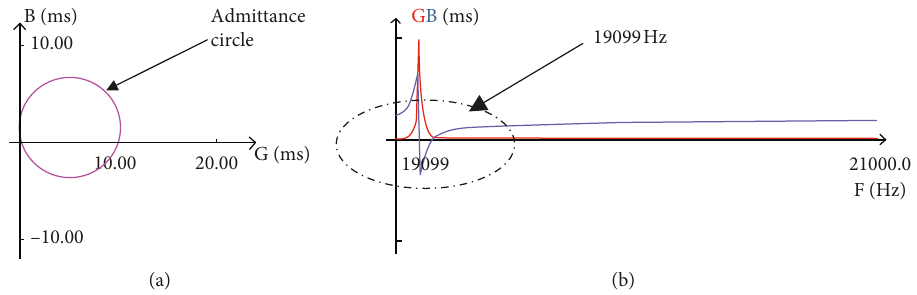
Figure 8: The measurement result of frequency. (a) Admittance circle. (b) Response frequency.